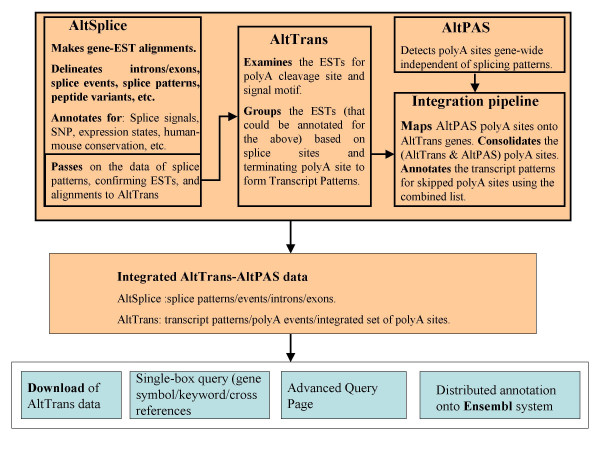
Illustration of the relationship between the AltTrans, AltSplice, and AltPAS pipelines/data.